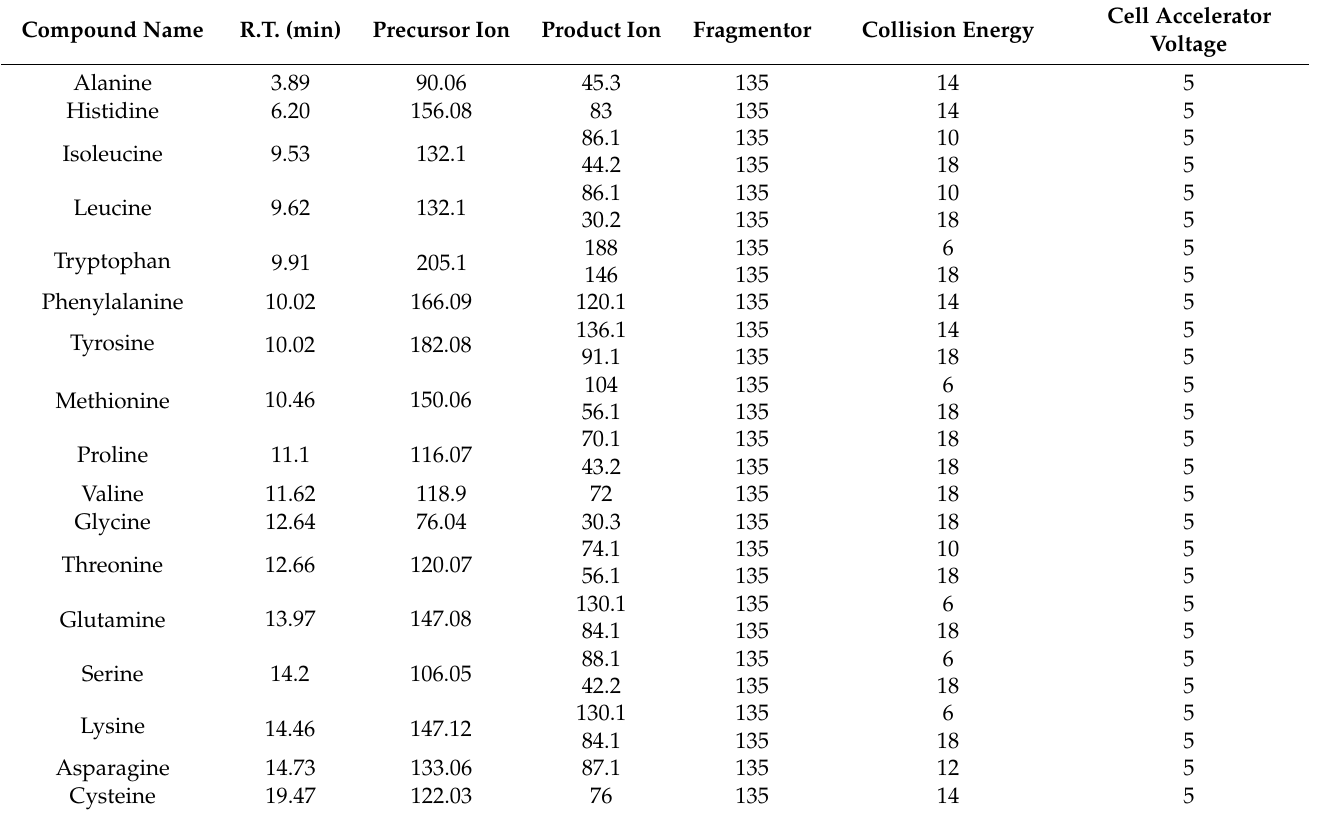
Table 2. Amino acids and LC–MS/MS-MRM m / z ions used for qualitative and quantitative analysis.